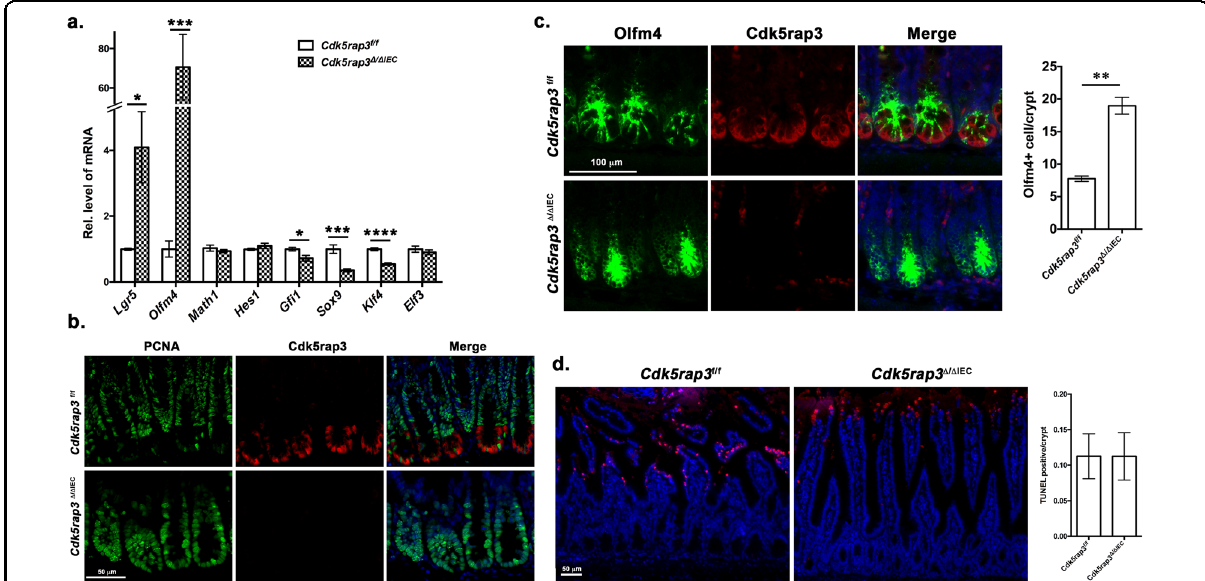
Fig. 2 Cdk5rap3 deletion impairs fate speci fi cation of Paneth cell lineage. a Quantitative RT-PCR analysis of speci fi c genes involved in intestinal stem cell renewal and differentiation. Total RNA was isolated from intestinal scrapes and used for qRT-PCR analysis. * p < 0.05, ** p < 0.01, *** p < 0.001, **** p < 0.0001 ( n = 4 mice per genotype). b Proliferating cells at the crypt base of wild-type and Cdk5rap3 de fi cient small intestine. Ileal sections were so-stained with PCNA and Cdk5rap3 antibodies. c Olfm4 staining of wild-type and Cdk5rap3 Δ / Δ IEC ileal sections. Olfm4 + cells per crypt were scored and compared. ** p < 0.01. ( n = 4 mice per genotype). d TUNEL staining of wild-type and Cdk5rap3 Δ / Δ IEC ileal sections. TUNEL positive cells per crypt were scored from four mice of each